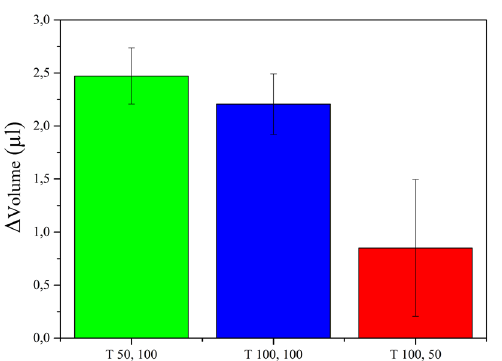
Figure 6. Measurement of drop absorption using the volume method of the semi-spherical cap To elucidate the results, spectral reflectance analyzes were performed on the plasma treated samples and compared to the untreated surface of the polished substrate. As expected, all plasma-treated samples became optically selective (Figure 7). It was found that at wavelengths less than 650 nm, the percentage of reflected light was lower than that of polished aluminium. For surfaces with a mean pore size of than the others. The surfaces with a pore size of 2.53 µm